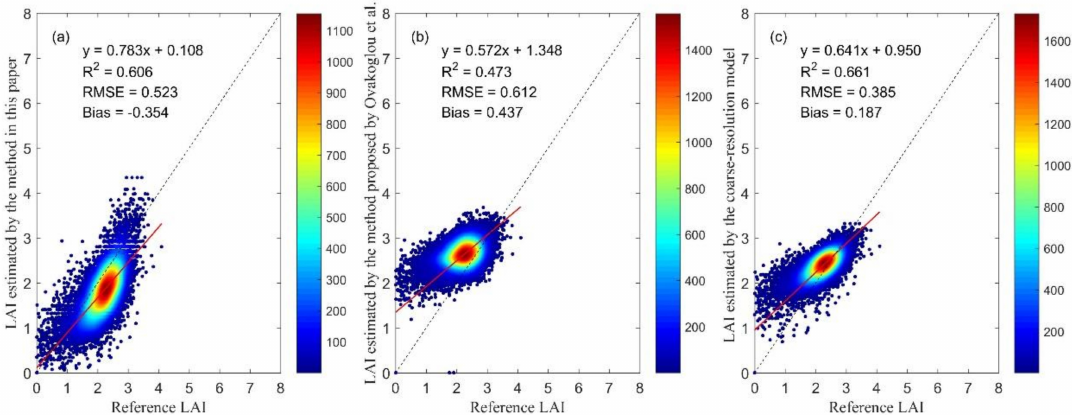
Figure 13. Scattering density map between the estimated LAI map and the reference LAI map at the Camerons site. ( a ) Based on the downscaling method proposed in this paper; ( b ) based on Ovakoglou’s downscaling method; ( c ) based on the model F ( P )